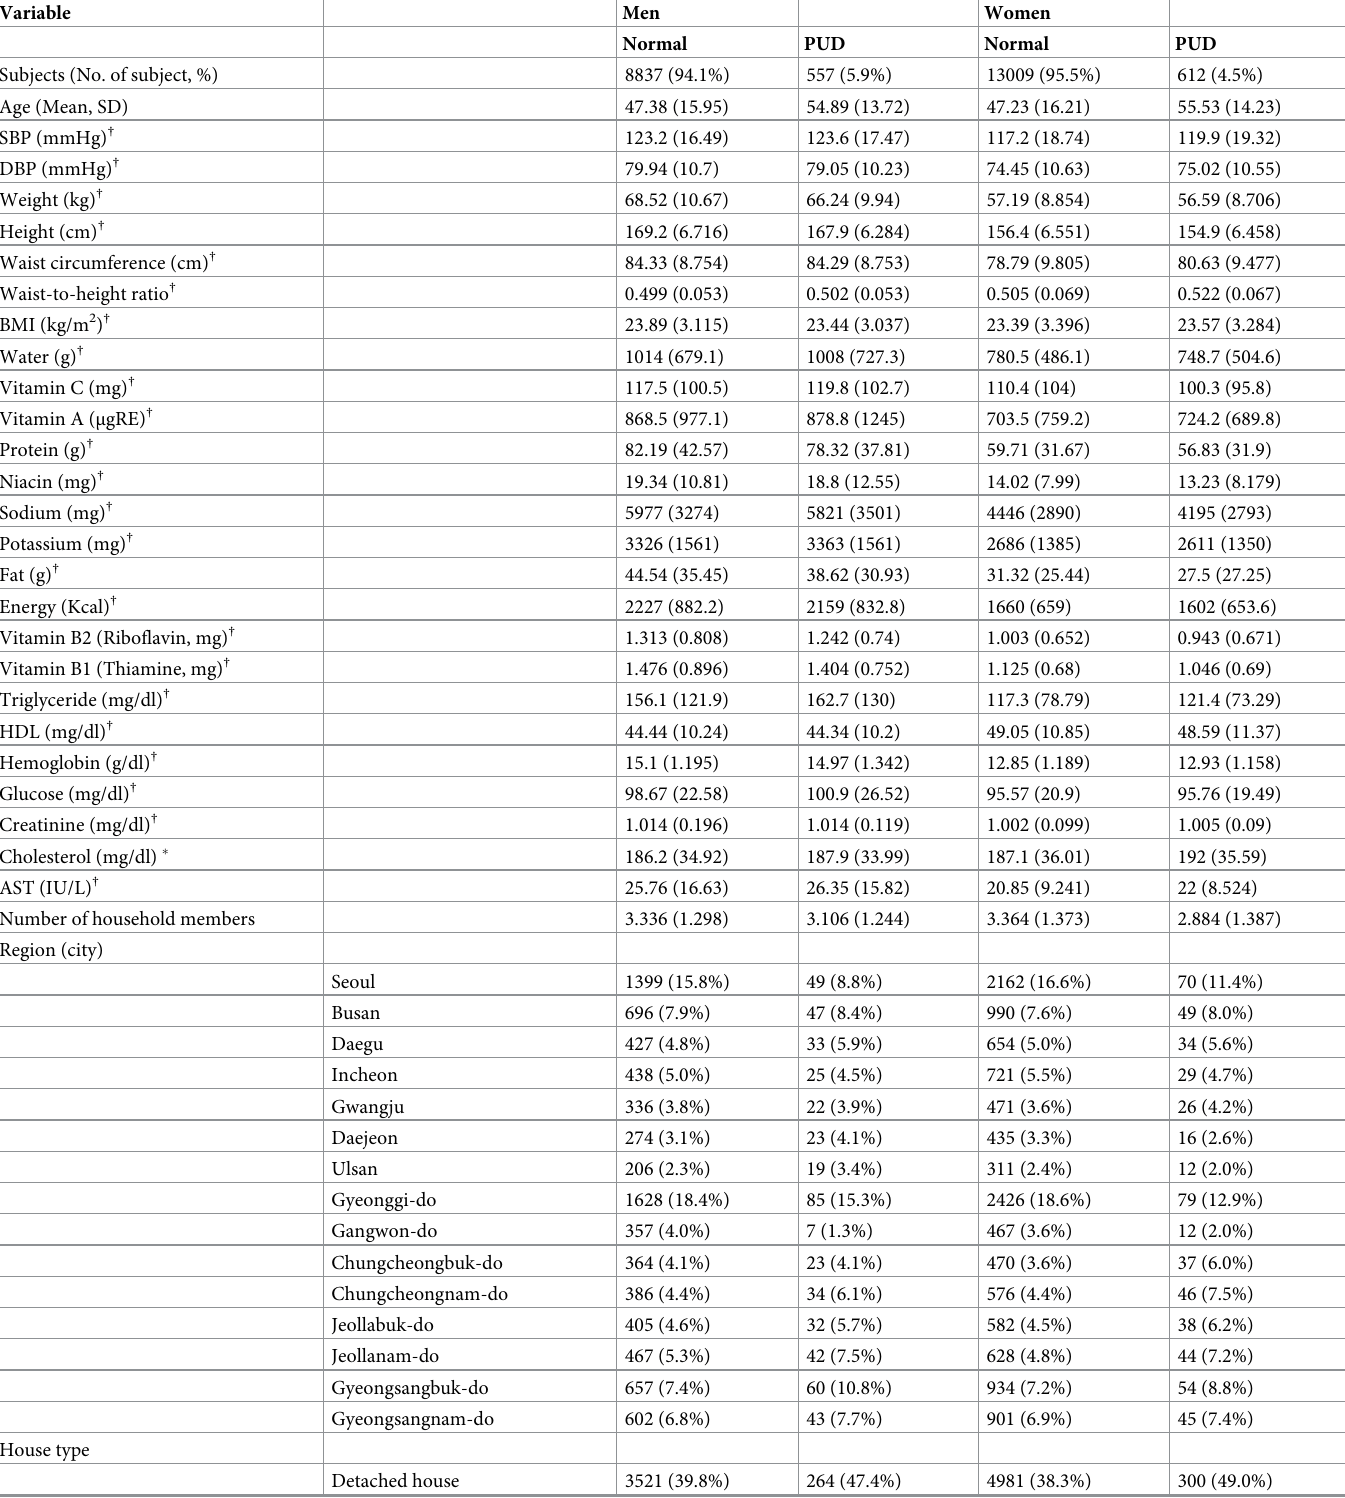
Table 1. Basic characteristics of all variables evaluated in this